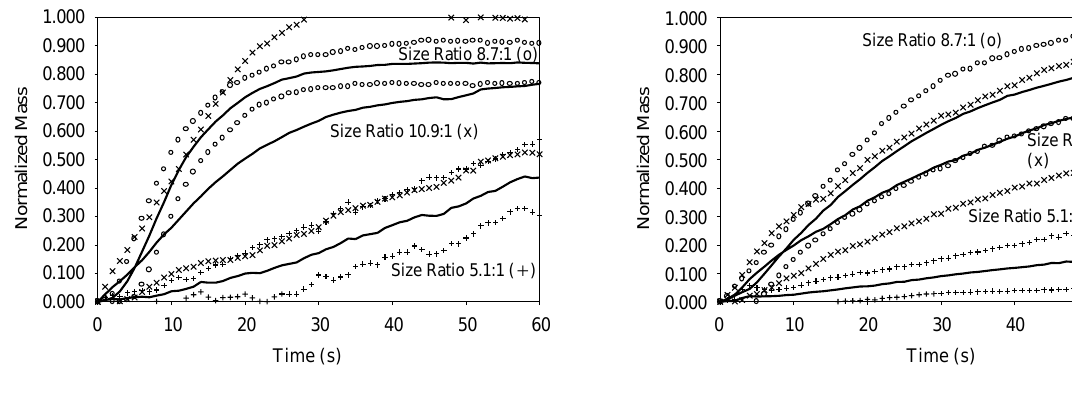
Fig. 6 Mean (solid lines) and 95% CI (symbols) for normalized mass as a function of time (cid:4) Strain (cid:6) 15%, Cycle Speed (cid:6) 1.33 cycles/second and Bed Depth (cid:6) 5.08 cm